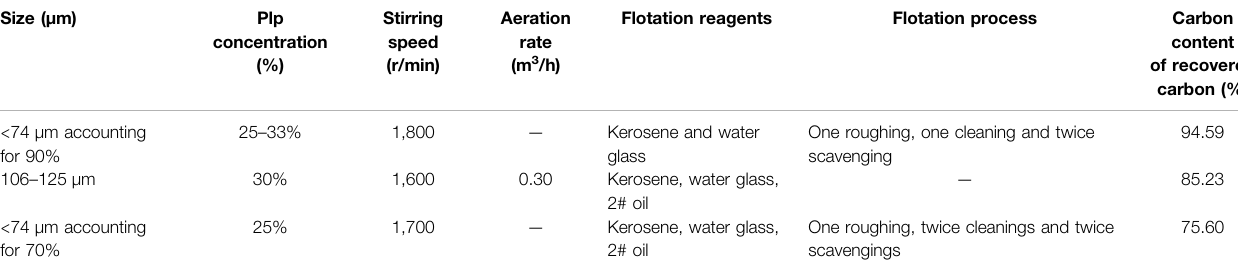
TABLE 2 | Summary of optimal parameters for SCA treatment with different fl otation